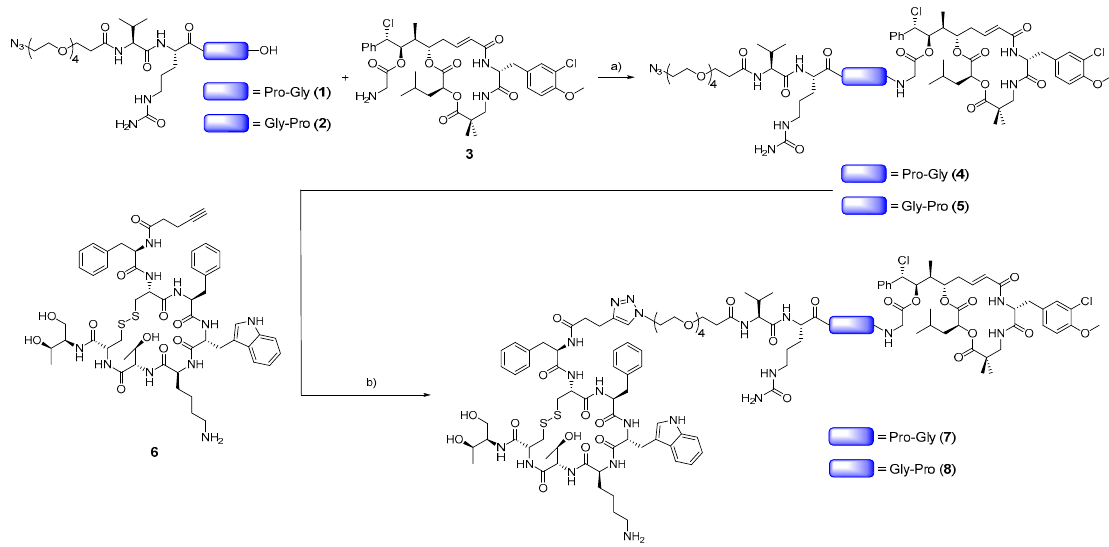
Scheme 1. Synthesis of octreotide-cryptophycin conjugates 7 and 8 . Reagents and conditions: a) 1 or